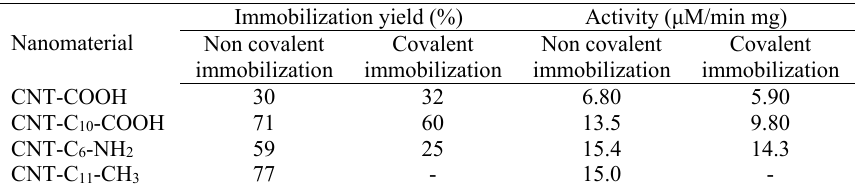
Table 1. Peroxidase activity and immobilization yield (%) of cyt c on f-MWCNTs, calculated as the ratio of protein immobilized on nanomaterials to the initial protein quantity used (standard deviation was less than 2% in all cases).